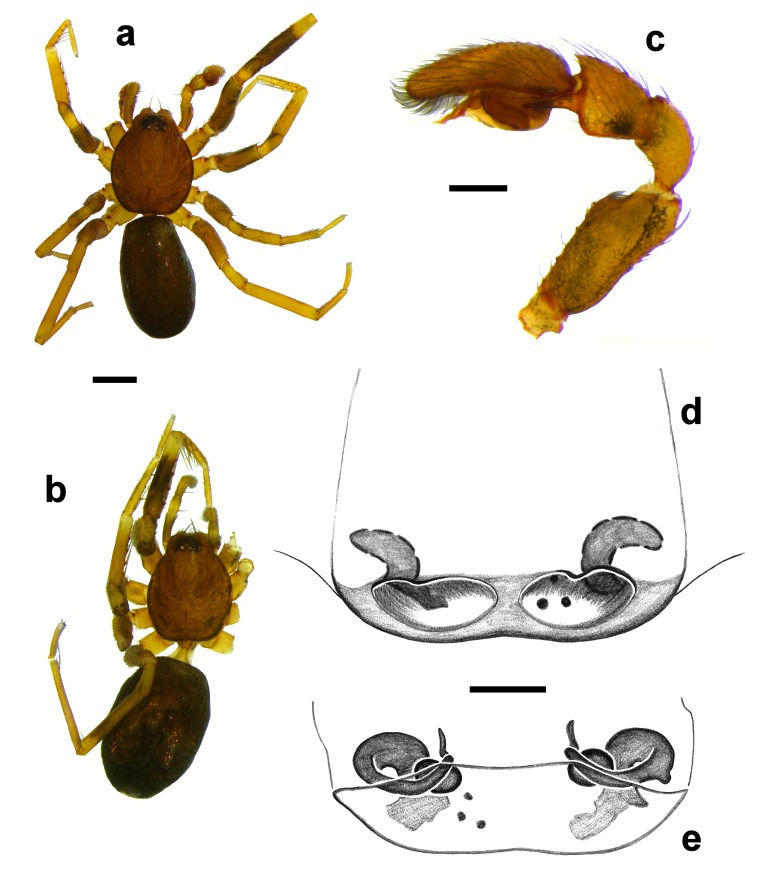
Phrurolinillus
tibialis (Simon, 1878). a: male, dorsal habitus, scale = 0.5 mm; b: female, dorsal habitus, scale = 0.5 mm; c: left male palp, retrolateral, scale = 0.2 mm; d: female epigynum, ventral, scale = 0.1 mm; e: female vulva, dorsal, scale = 0.1 mm.